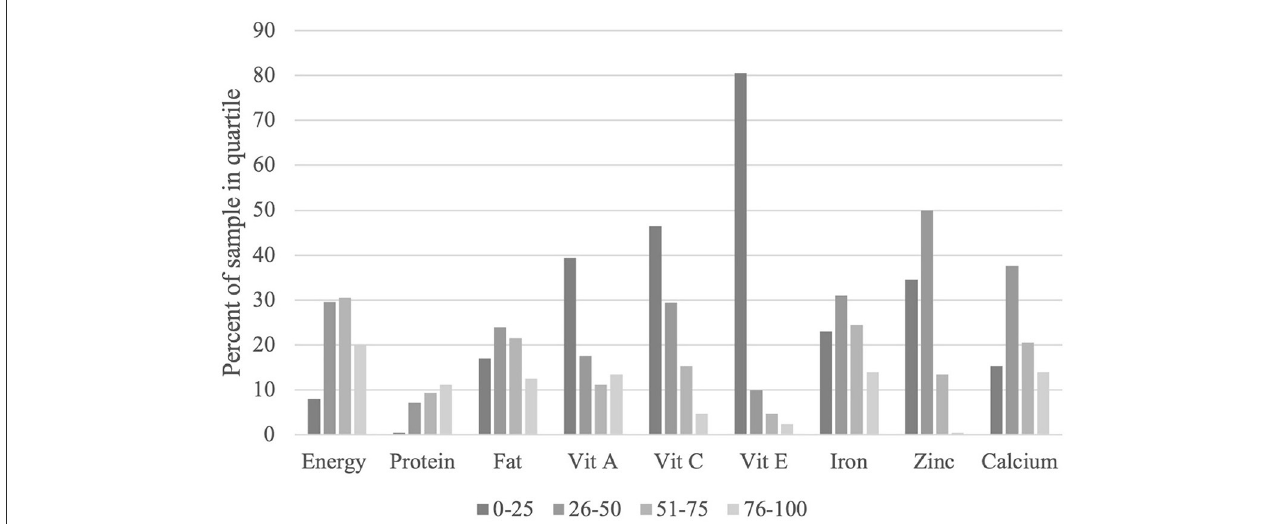
FIGURE1 Percent of children in quartiles of nutrient adequacy. Percent of children falling into quartiles of nutrient adequacy cut-points. When percentages across quartiles of nutrient inadequacy do not sum to 100, the remaining children showed dietary intakes greater than required levels (Supplemental Table 2). Reference levels were taken from FAO ( Human and Vitamin and Mineral Requirements, FAO/WHO., 2001) and the Kenyan National Clinical Nutrition and Dietetics reference manual (1st Ed, Feb, 2010). Based on a predominantly plant-based diets, we set iron bioavailability at 5%, and zinc considered “low bioavailability” (FAO/WHO.,